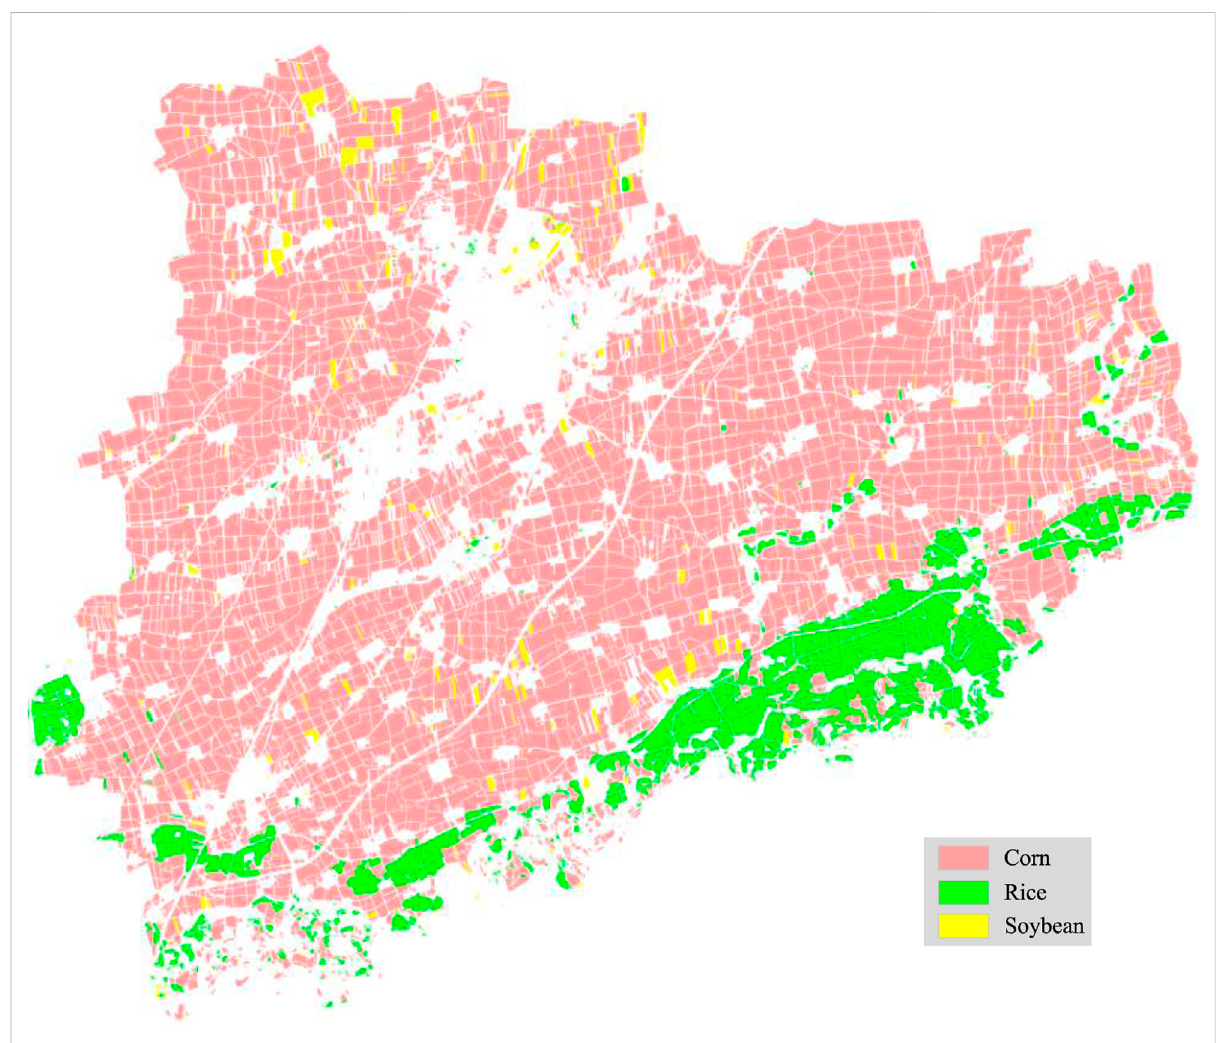
FIGURE 14 The classi fi cation result of CSNet